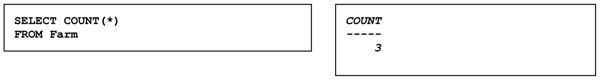
Query to count number of rows in the Farm table